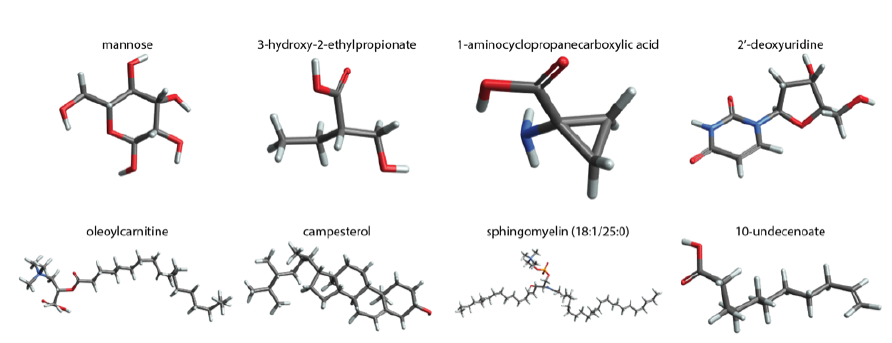
Figure 1. Names and structures of the eight metabolites with significantly altered fold changes ( p < 0.05). Metabolites exhibited increased fold changes for KO versus WT ratios with the exception of sphingomyelin and campesterol (which were both decreased). Standard color schemes for the wire structures are used (e.g., carbon: gray, oxygen: red, nitrogen: blue, hydrogen: white).